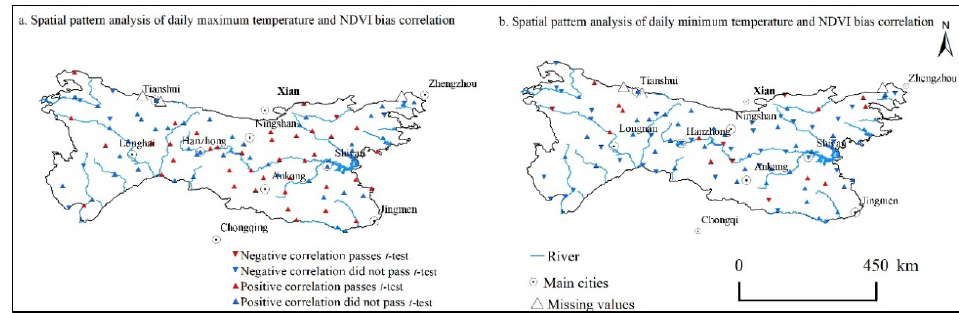
Figure 5. Second-order partial correlation analysis of NDVI with T max ( a ) and T min ( b ) in the Qinba Mountains from 1982 to 2015.